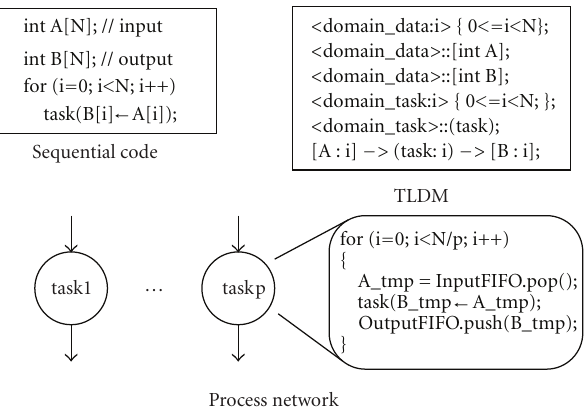
Figure 8: Implicit parallelism (TLDM) versus explicit parallelism (process